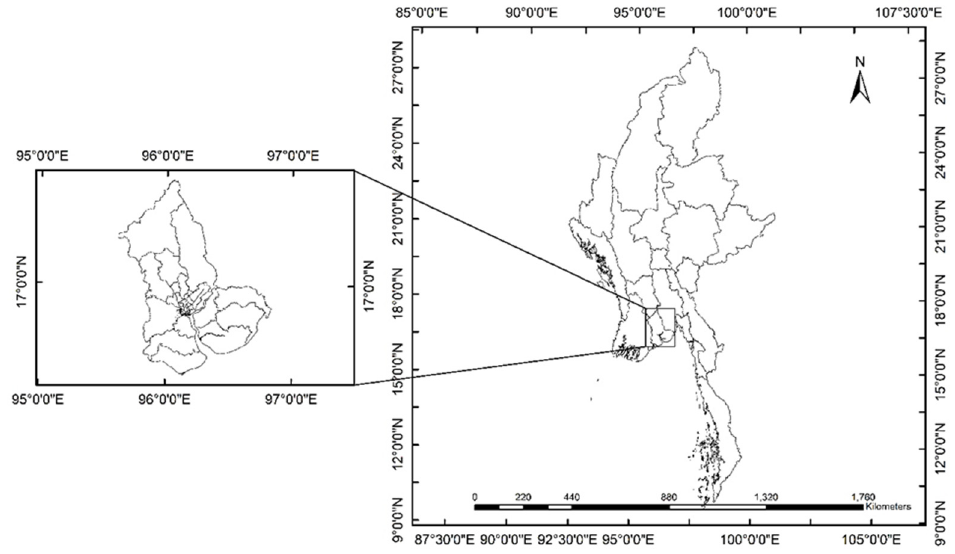
Figure 1. Study Area of Yangon Region, Myanmar.